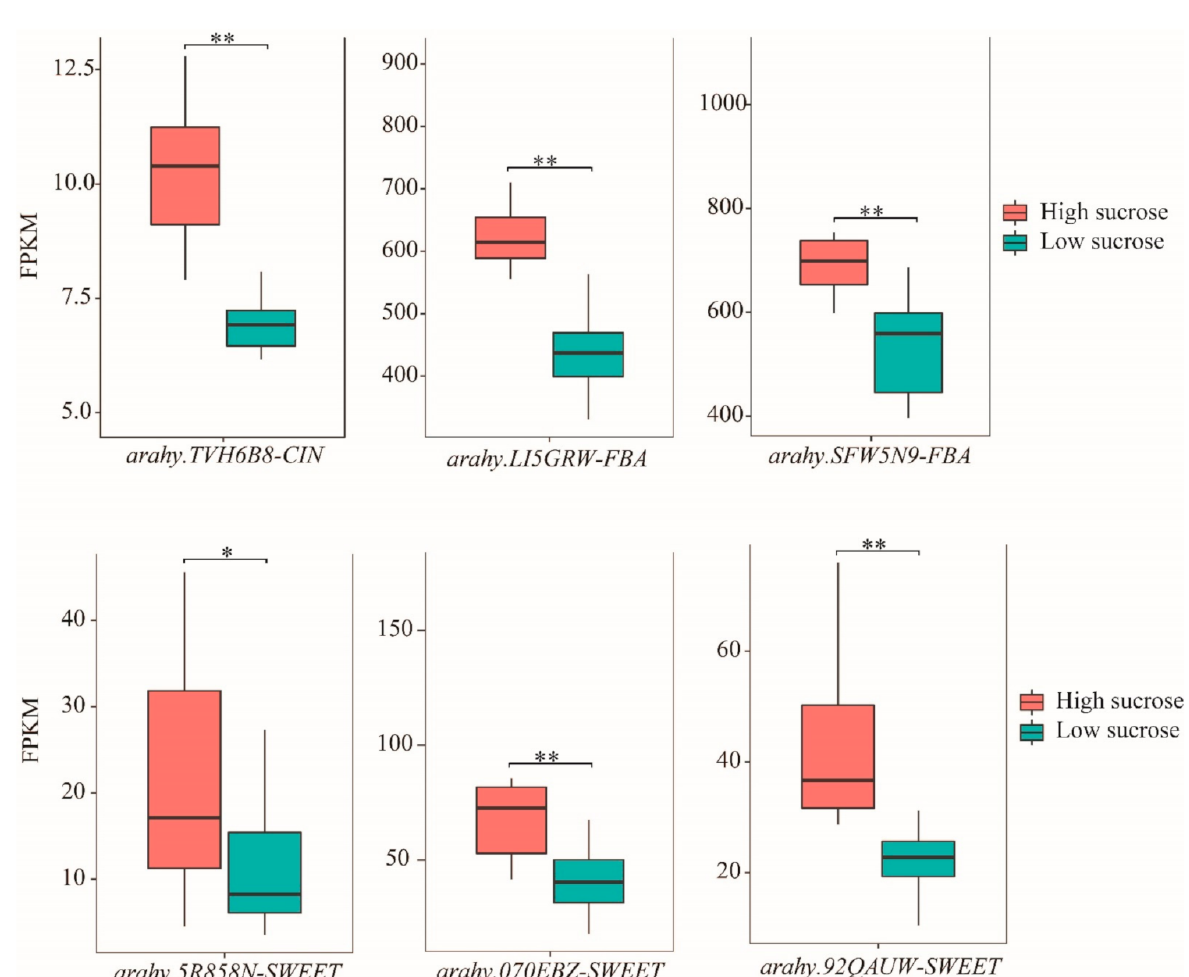
Figure 8. Expression level of six genes in the RIL lines with high sucrose and low sucrose. In each box, centerline shows the median; box limits indicate the 25th and 75th percentiles; whiskers extend 1.5 times the interquartile range from the 25th and 75th percentiles. Error bars represented standard errors ( n = 12). Within plots, the “*” and “**” indicates statistically significant differences at p < 0.05 and p < 0.01 according to independent samples t -test,